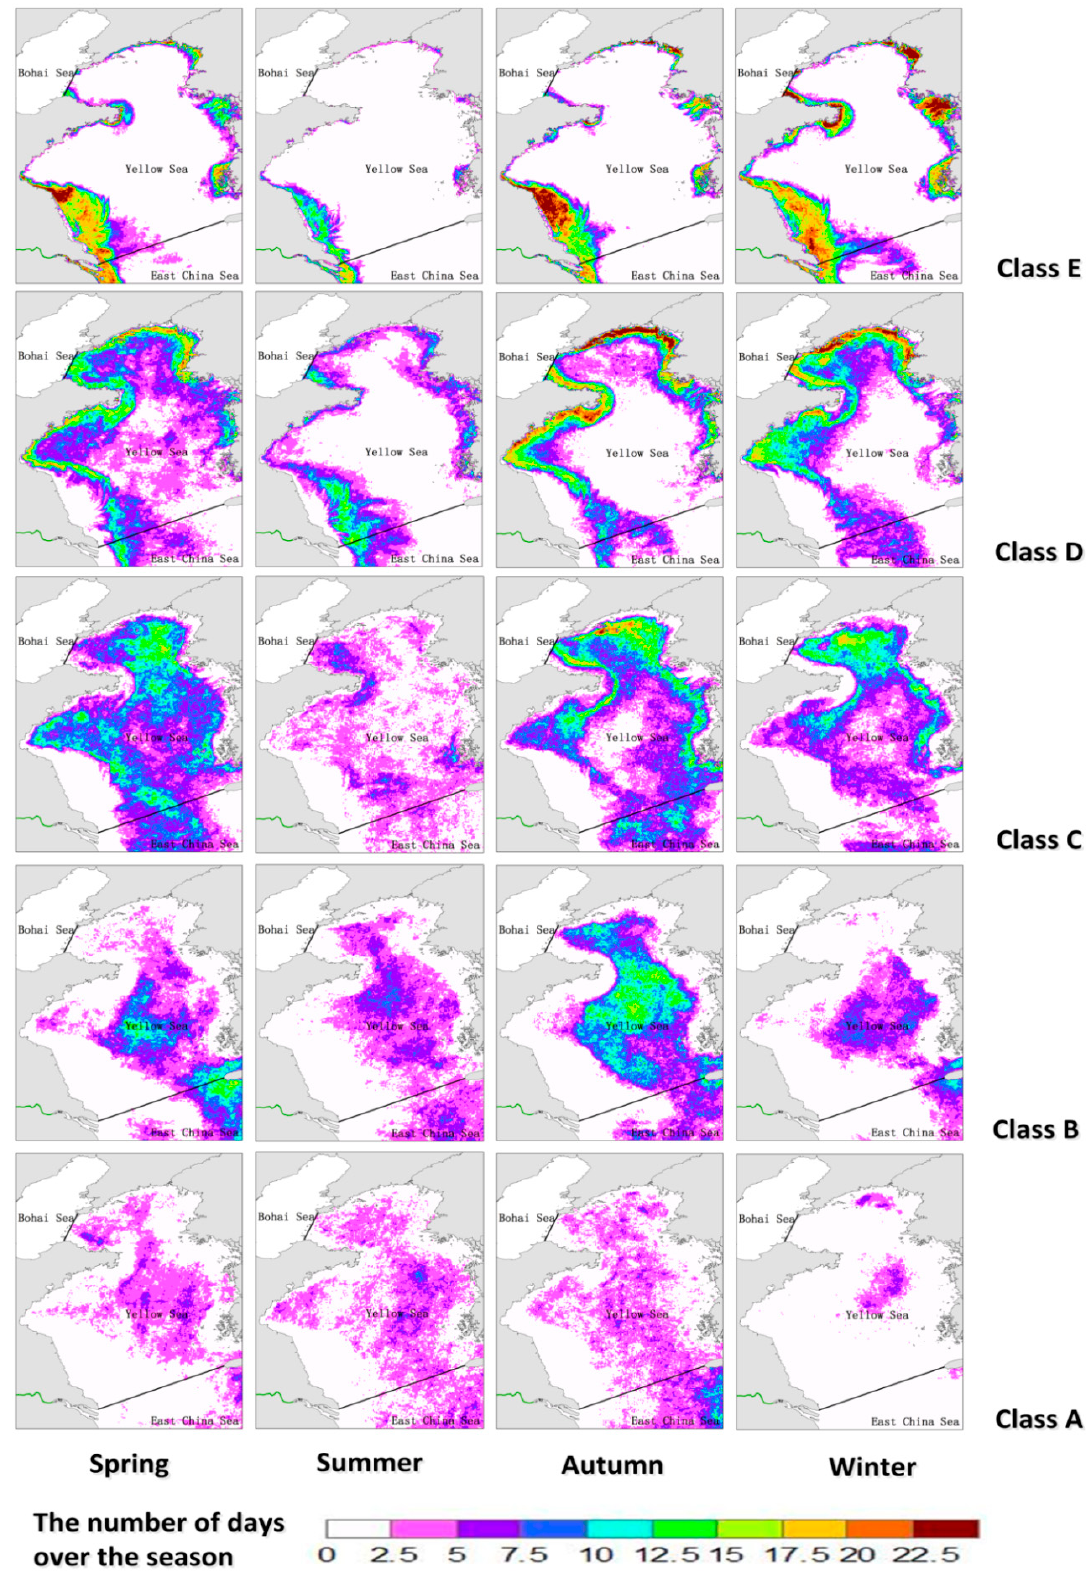
Figure 11. Seasonal accumulative frequency distzributions of water types (Classes E–A, up to down) for the four seasons (summer (1 June–31 August) and winter (1 December–28 February) in 2006/2007, and spring (1 March–30 May) and autumn (1 September–30 November) in 2007) corresponding to four survey cruises in 2006–2007. The color bar at the bottom represents the number of days over the season.